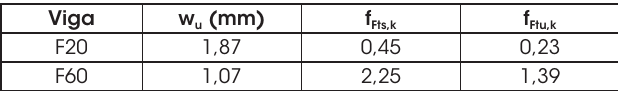
Valores de cálculo adotados para a